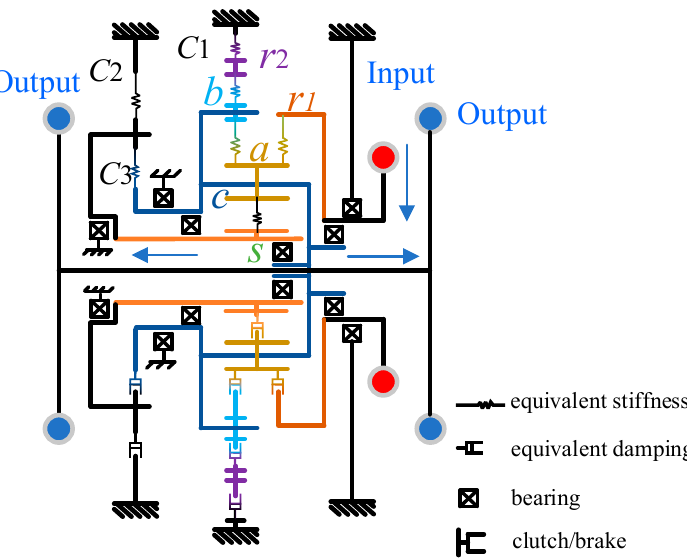
Figure 1. Schematic of the compound planetary transmission system. To describe the meshing relationship between planetary gear systems more accurately, three coordinate systems are used in this paper: the first is the absolute coordinate system X _ O _ Y , which is used to describe the vibration displacement of all central rotating parts; the second is the involved coordinate system X i _ O i _ Y i , which describes the translational vibration displacement and which rotates synchronously with the planetary shelf; the third is the relative coordinate system x aj _ O aj _ y aj of the jth planetary wheel in the planetary row of a or b, whose origin is located in the center of each planetary wheel, and its coordinate axis is orthogonally along the radial and circumferential directions of the planetary carrier. In the dynamic model of the composite planetary gear system established in this paper, the vibration displacement of planetary gear is based on their respective relative coordinate systems x aj _ O aj _ y aj . The bending–torsion coupling mechanical model of the composite planetary gear system is shown in Figure 2. k msaj , k mraj , k mrbj and k mabj are the meshing stiffness of the meshing pair in the torsional direction; θ c , θ r 1 , θ r 2 , and θ s , respectively, represent the torsional displacement relative to the fixed reference frame X _ O _ Y ; θ aj and θ bj indicate the relative torsional displacement of the planet wheel a j and the planet wheel b j in the relative coordinate system x aj _ O aj _ y aj , x bj _ O bj _ y bj , where j = 1, 2, 3; k bpx , k bqx , k bpy , and k bqy express the supporting stiffness of p and q in the x direction and y direction in their respective coordinate systems, where p = s , c , r 1 and r 2, respectively, mean the sun wheel, planet rack, small ring gear and large ring gear in